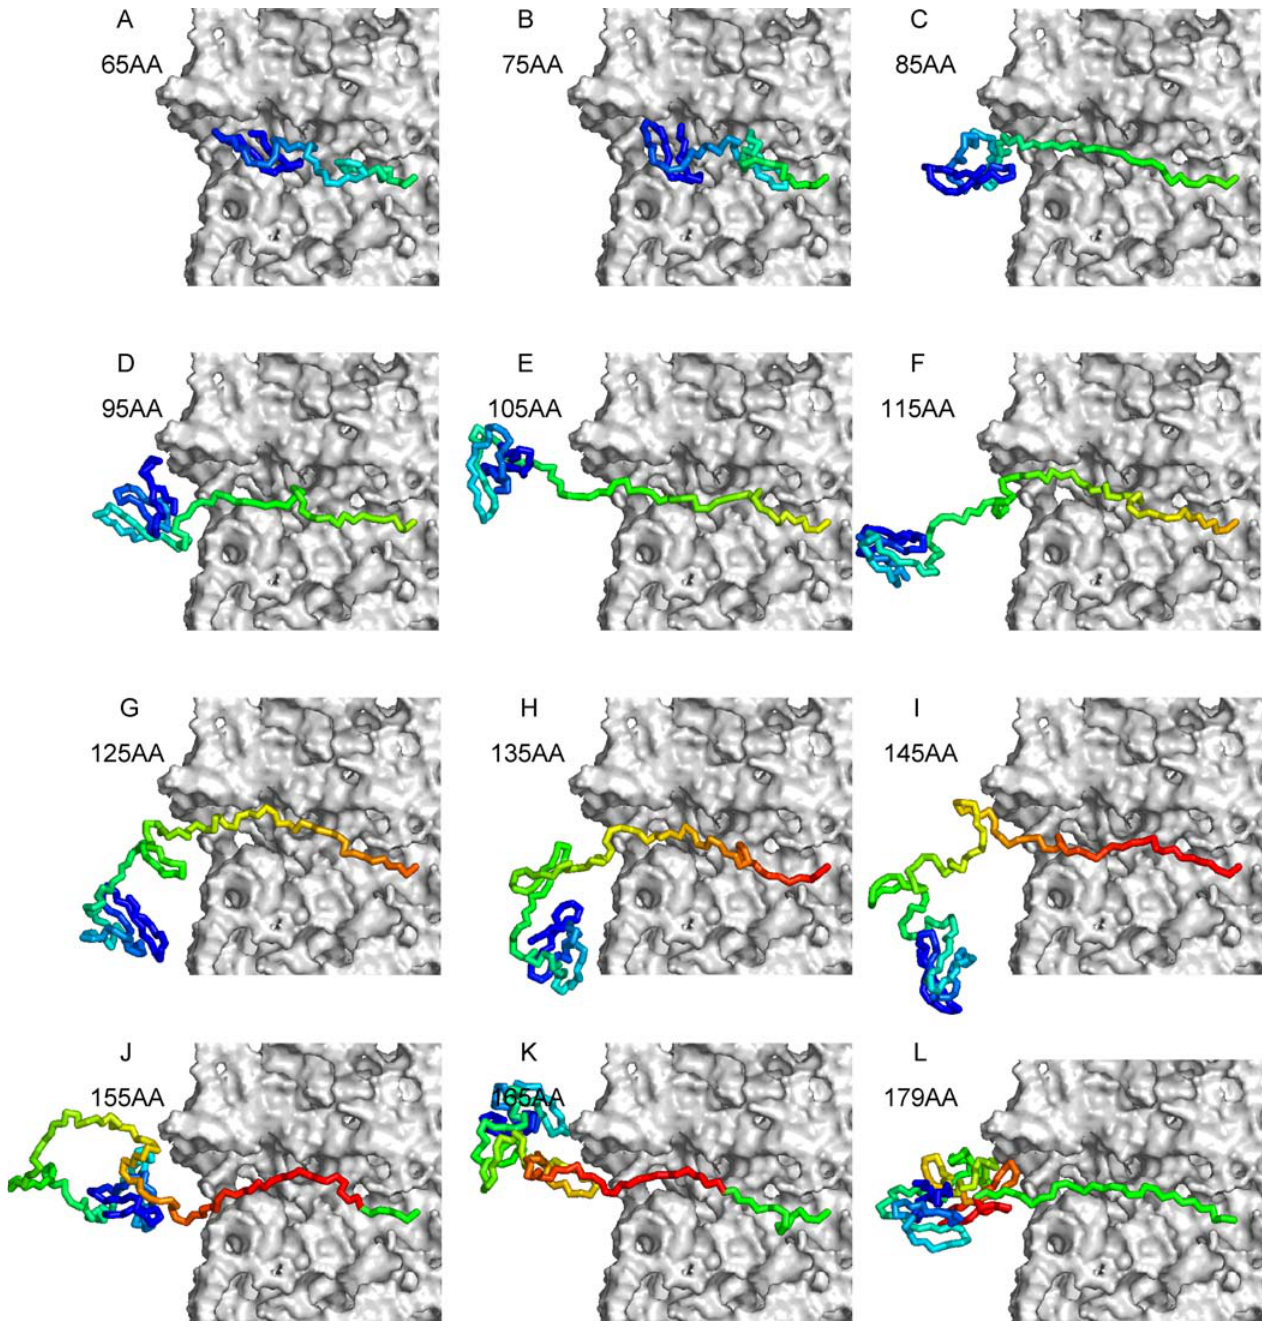
Figure 10. A Typical Coupled Synthesis–Folding Simulation of SFVP Snapshots from a typical de novo folding simulation of SFVP in the presence of the ribosome (grey surface). The nascent chain is colored from blue (N- terminus) to red (C-terminus), with its length (in amino acids) indicated in each panel. This figure was prepared with